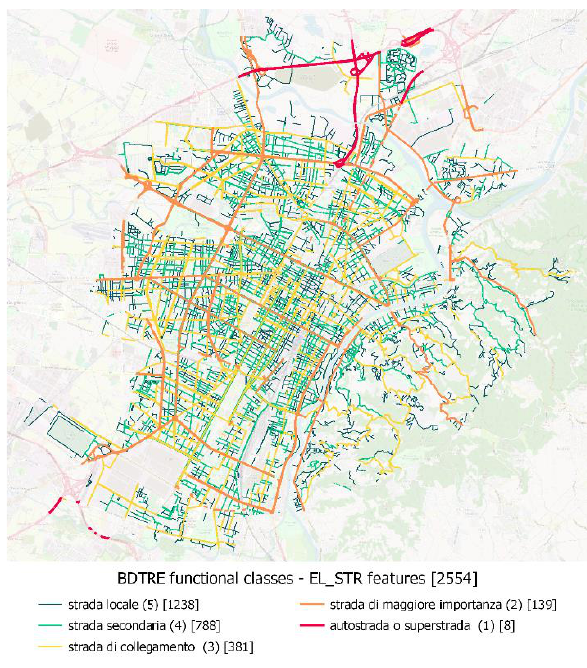
Figure 1 - BDTRE functional classes in the city of Torino (in brackets the relative hierarchical level, in square brackets the number of network elements in each class).